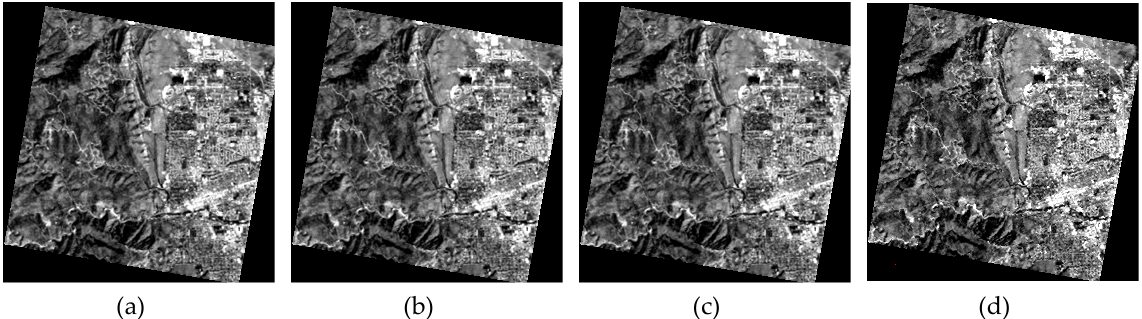
Figure 22. The georeferenced image of the first data set. ( a ) By FPGA. ( b ) By MATLAB. ( c ) By Visual Studio (C++). ( d ) By ENVI 5.3.